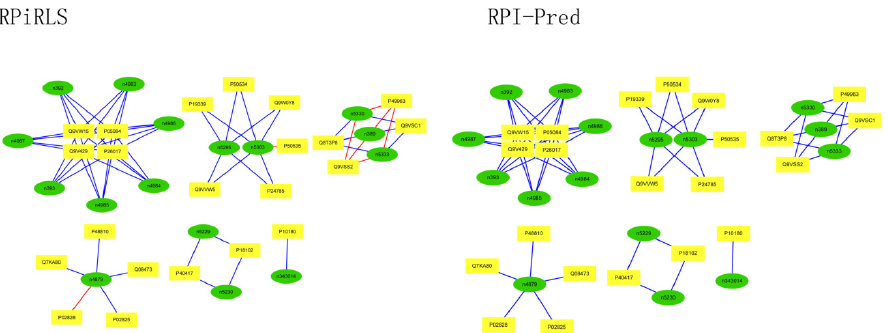
Figure 2. Comparison of the long non-coding RNA-protein interaction networks predicted by the RPiRLS and RPI-Pred methods, for Drosophila melanogaster